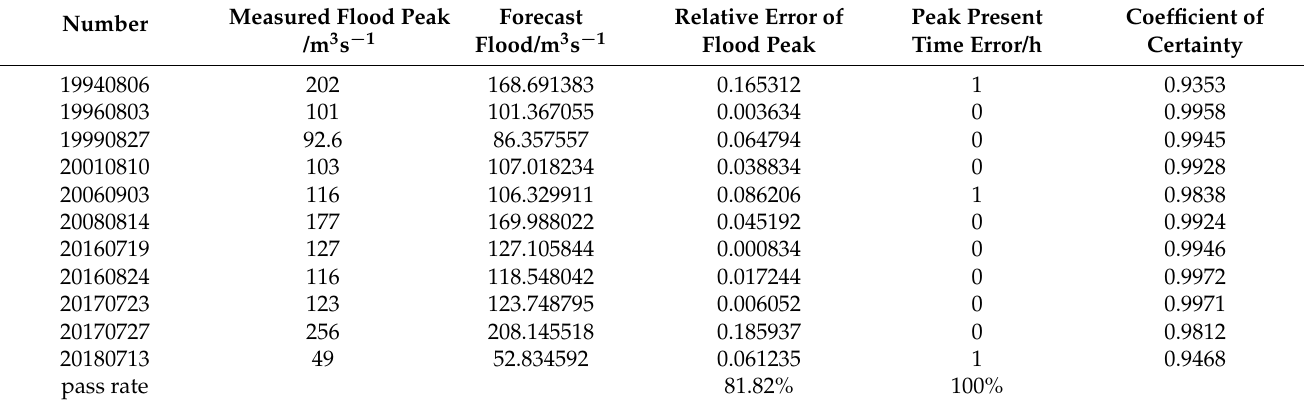
Table 2. Analysis of BP neural network prediction results.